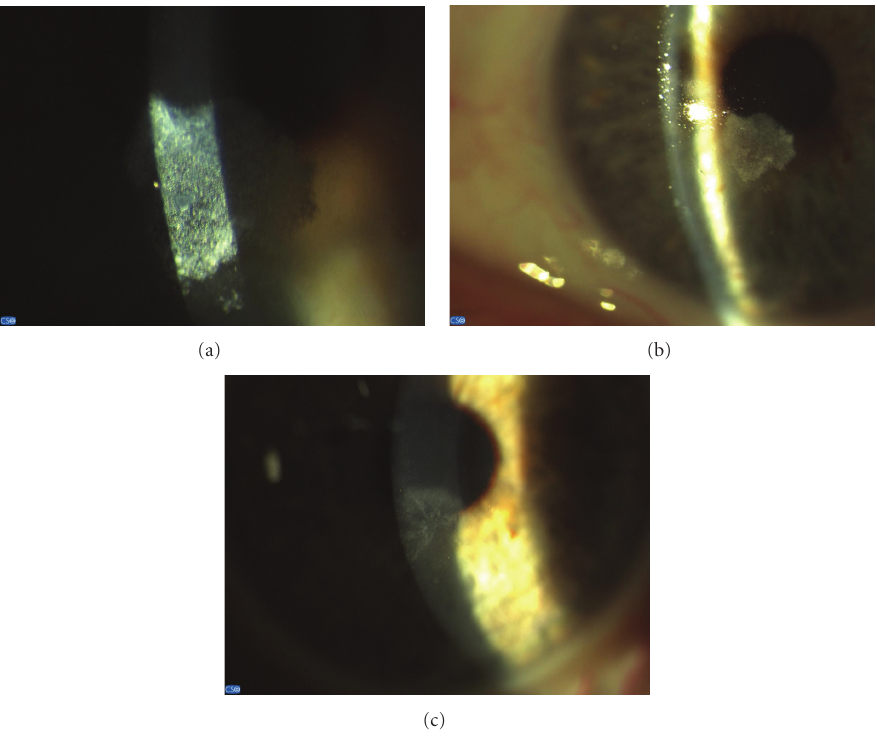
Figure 1: Shows the microcistic “caramel-like” opacity of subepithelial, paraoptic, inferior corneal stroma with epithelial discontinuities as appeared in the beginning (a, b) and after discontinuation of ciprofloxacin